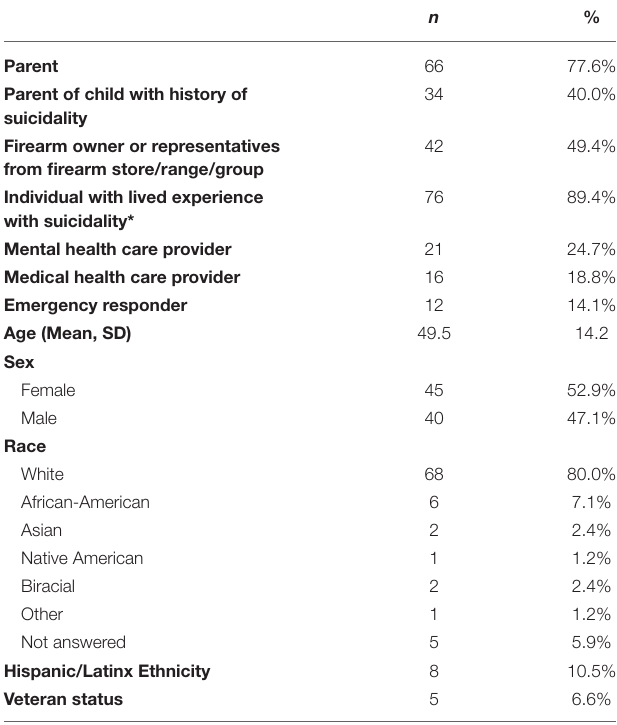
TABLE 1 | Demographic characteristics ( N = 85